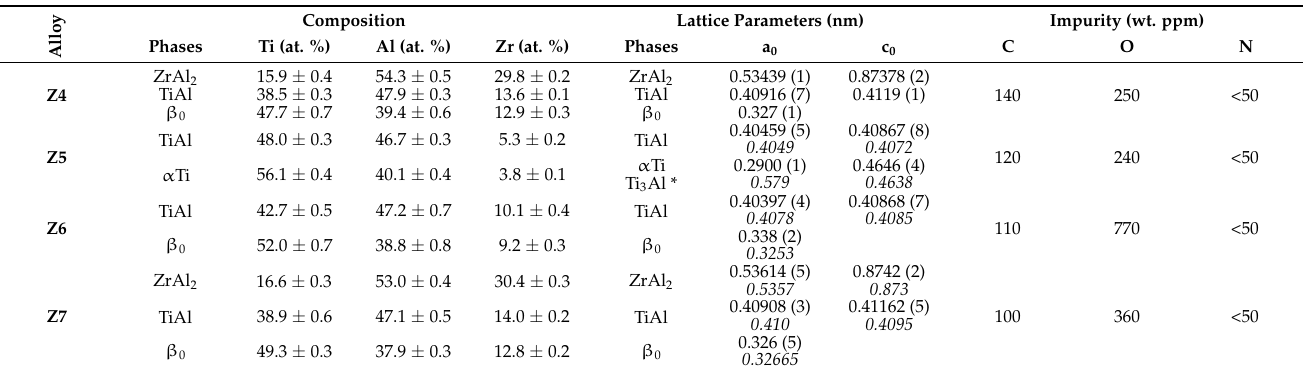
Table 5. Compositions and lattice parameters of the coexisting phases and impurity contents of samples heat treated at 1200 ◦ C/24 h; data shown in italics are from HE-XRD; phases marked with an asterisk (*) ordered during quenching.